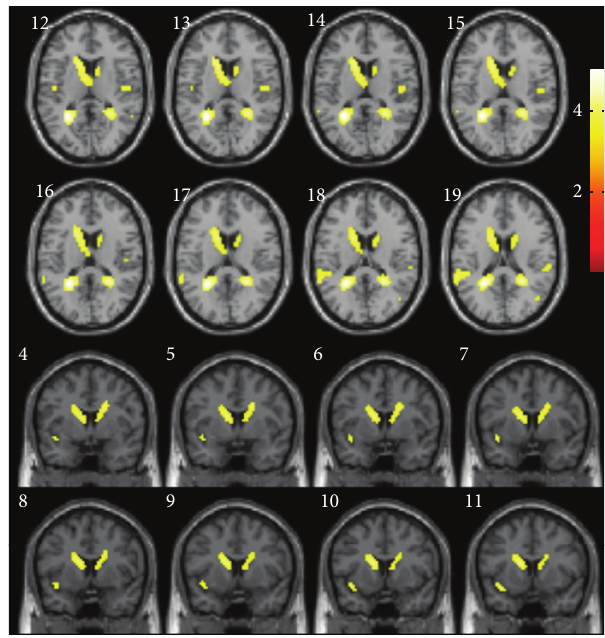
Figure 4: Voxel-based morphometry results showing regions pos- itively correlated with normalized ratio of insula volume (yellow, uncorrected 𝑃 < 0.001